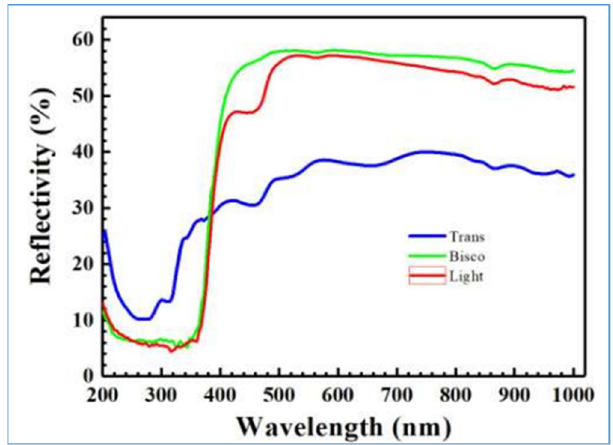
Figure 2. The spectra relating to the reflectivity of each orthodontic adhesive resin.